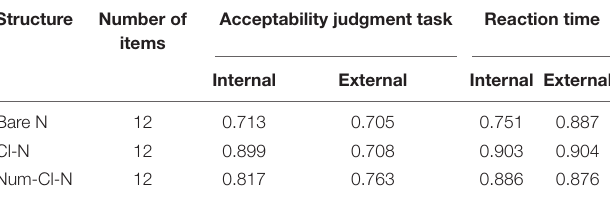
TABLE 1 | Coefficient alpha estimates by scale.